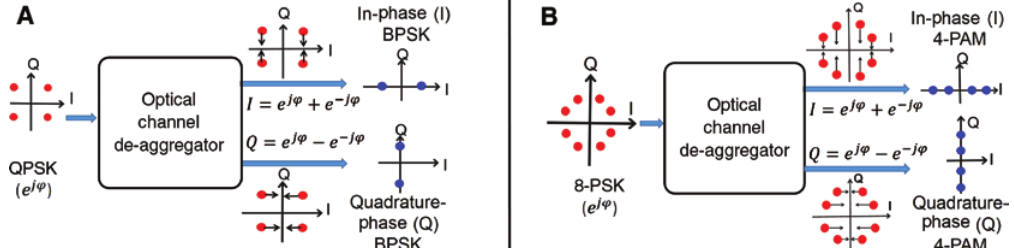
Figure 31: Deaggregation concept.